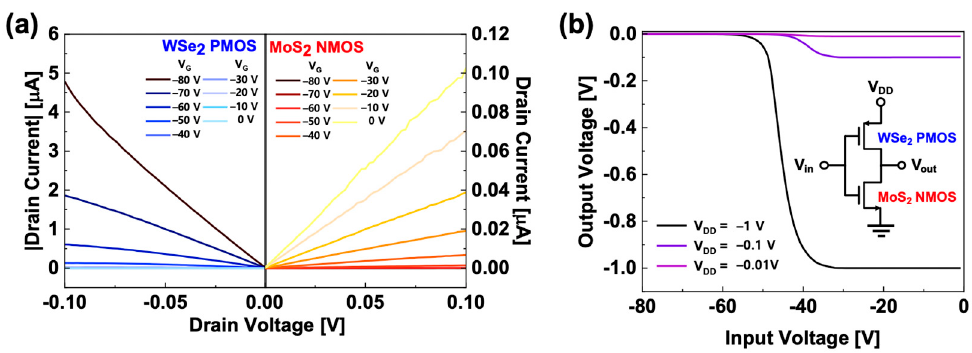
Figure 4. ( a ) Output characteristics curves of the WSe 2 field-effect transistors (FET) (driver) and MoS 2 FET (load) for complementary metal-oxide-semiconductor (CMOS) inverter circuit application; ( b ) VTC curves of our CMOS inverter circuit device at V DD of − 0.01 V, − 0.1 V, and − 1 V. The inset is the circuit diagram.